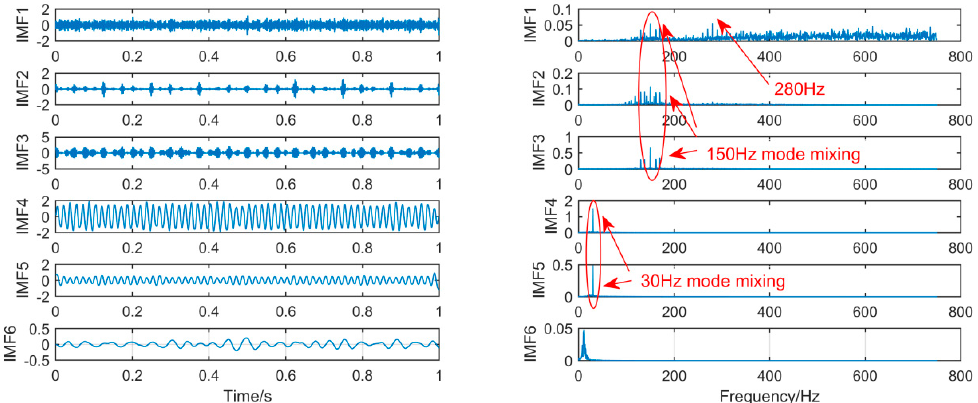
Figure 7. The spectrum of IMFs after CEEMDAN and its corresponding spectrum.